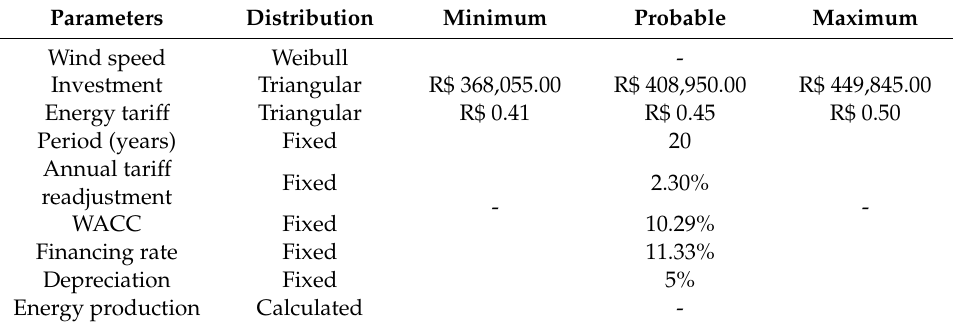
Table 1. Representation of cash flow, its values and